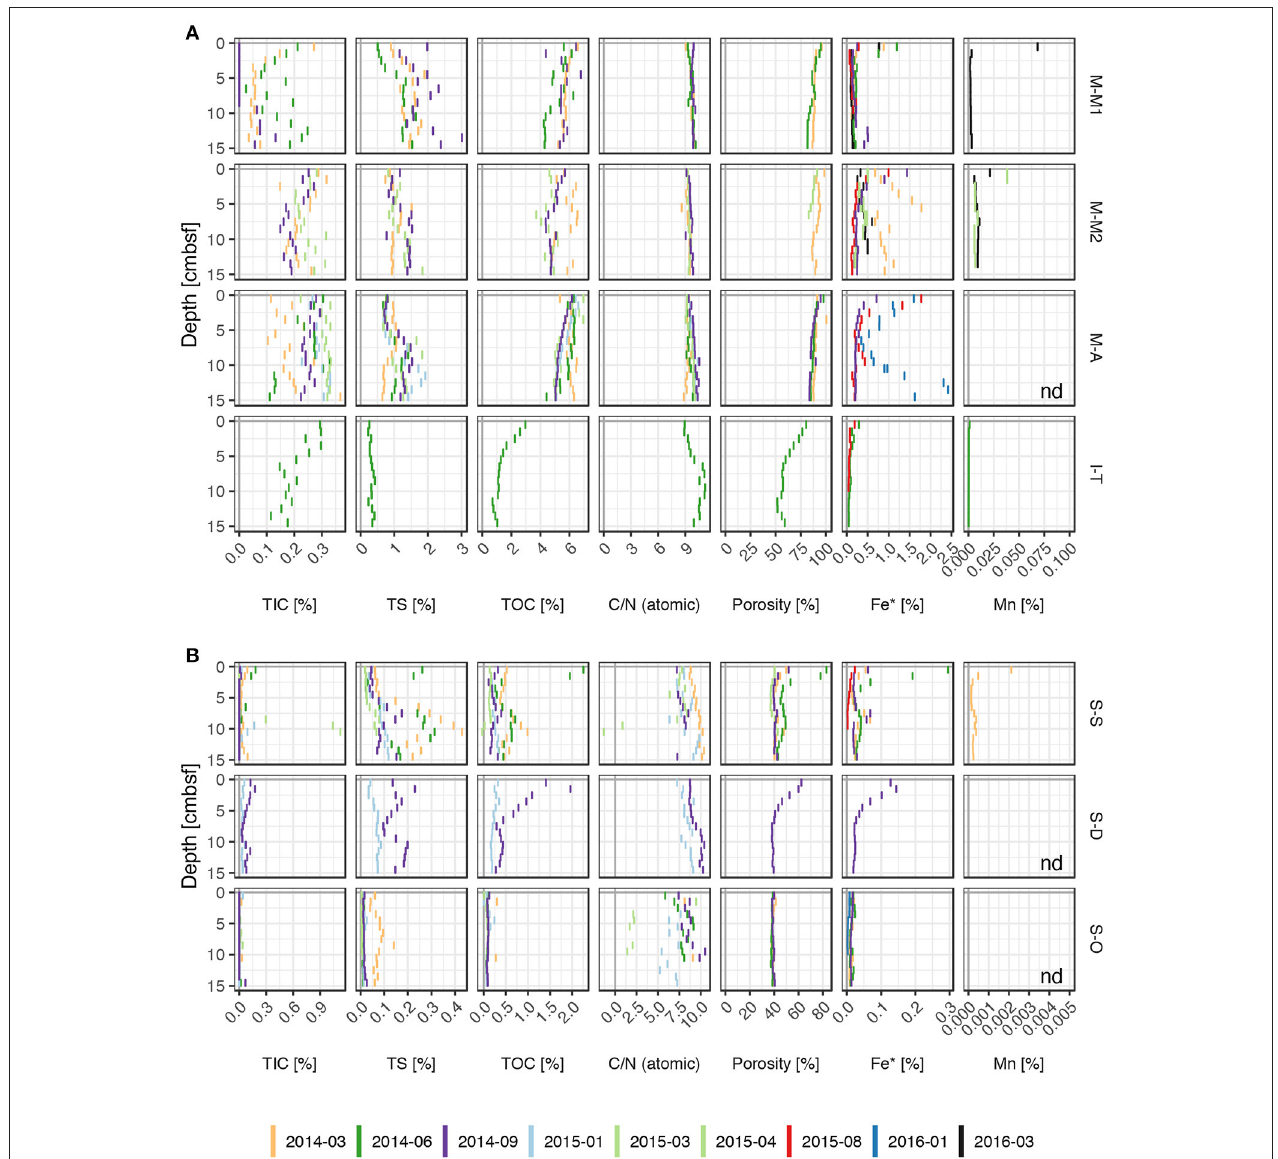
FIGURE 2 | Depth dependent dry mass content of sediment total inorganic carbon (TIC), total organic carbon (TOC), atomic TOC:TN ratio, reactive iron (Fe*), and acid extractable manganese (Mn) in (A) silty/muddy and (B) sandy sediments. Each bar represents one sediment sample, bar heights indicate the sampling interval. nd, not